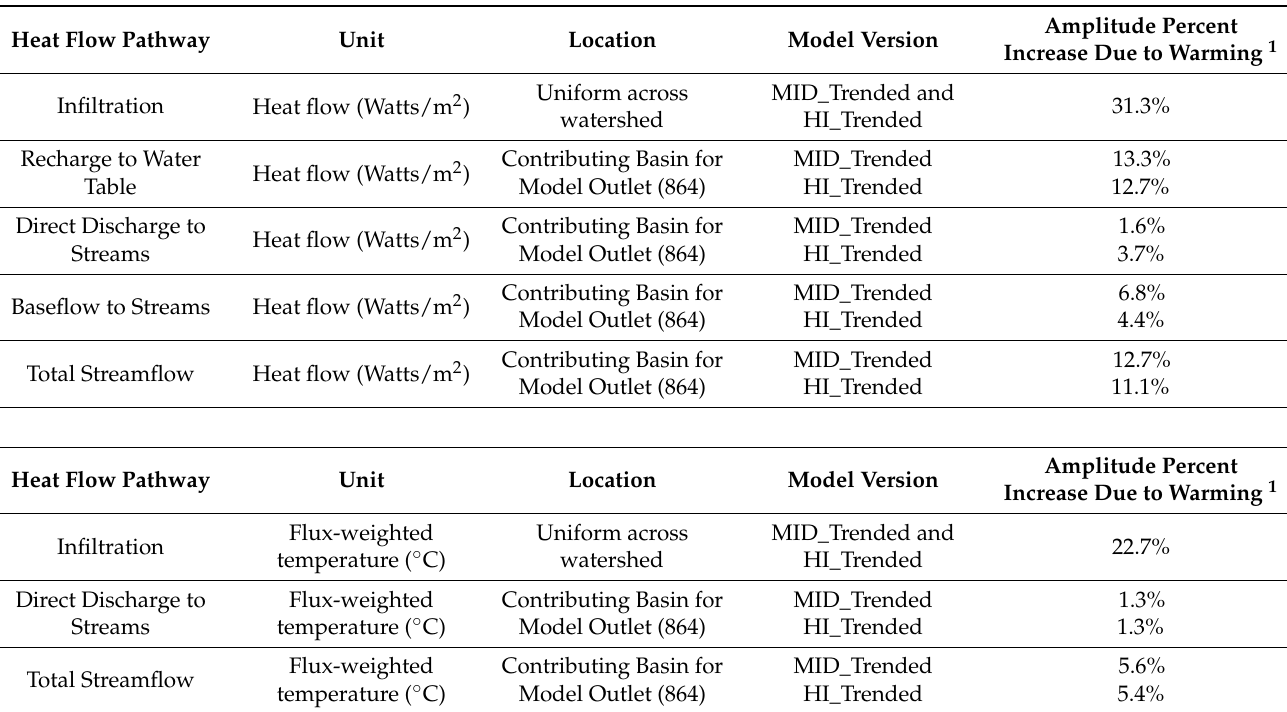
Table 2. Dampening of warming along watershed pathways: Attenuation of convective heat flow and temperature along pathways contributing to the 864 gage location for MID_TRENDED and HI_TRENDED simulations.